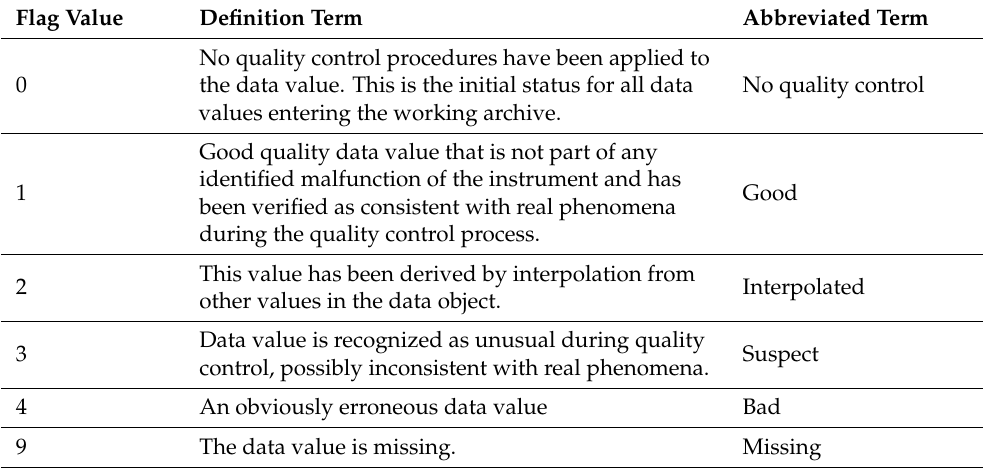
Table 2. Quality control flag values applied during the data processing.